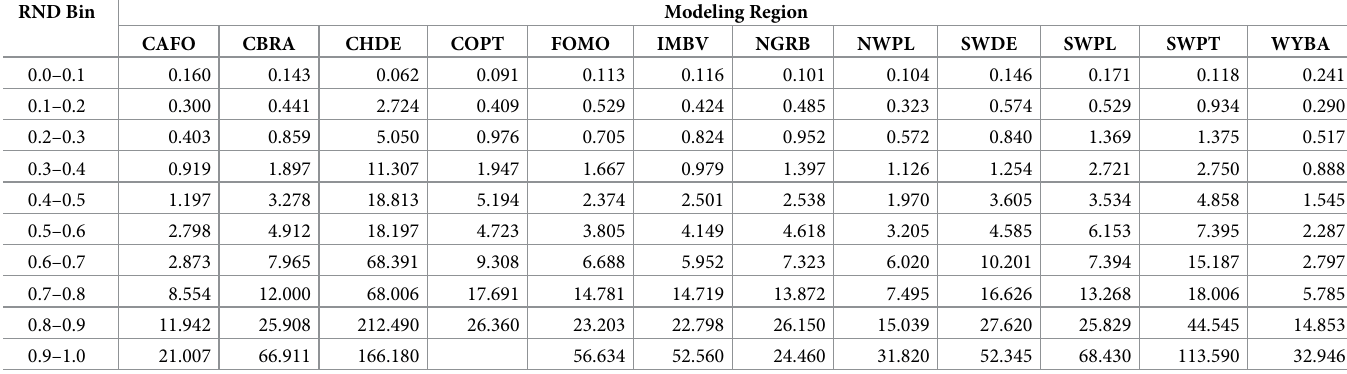
CAFO = California Foothills, CBRA = Central Basin and Range, CHDE = Chihuahuan Desert, COPT = Columbia Plateau, FOMO = Forested Montane, IMBV = Intermontane Basins and Valleys, NGRB = Northern Great Basin, NWPL = Northwestern Plains, SWDE = Southwestern Deserts, SWPL = Southwestern Plains, SWPT = Southwestern Plateaus, WYBA = Wyoming